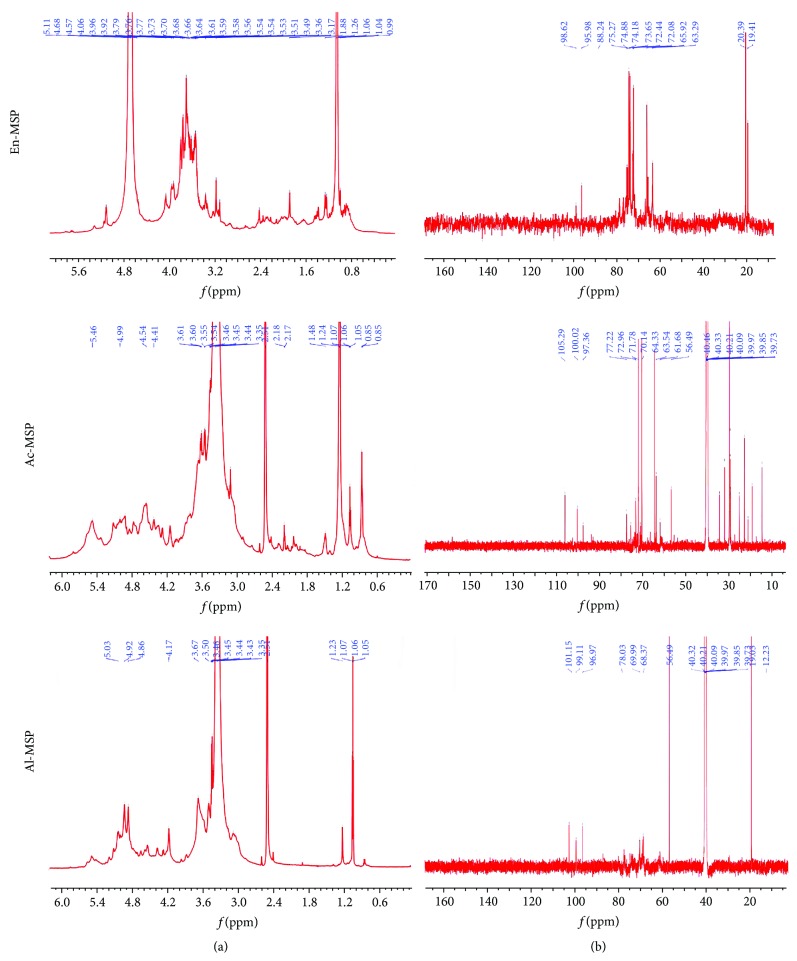
The 1H (a) and 13C (b) NMR analysis of En-, Ac-, and Al-MSP.